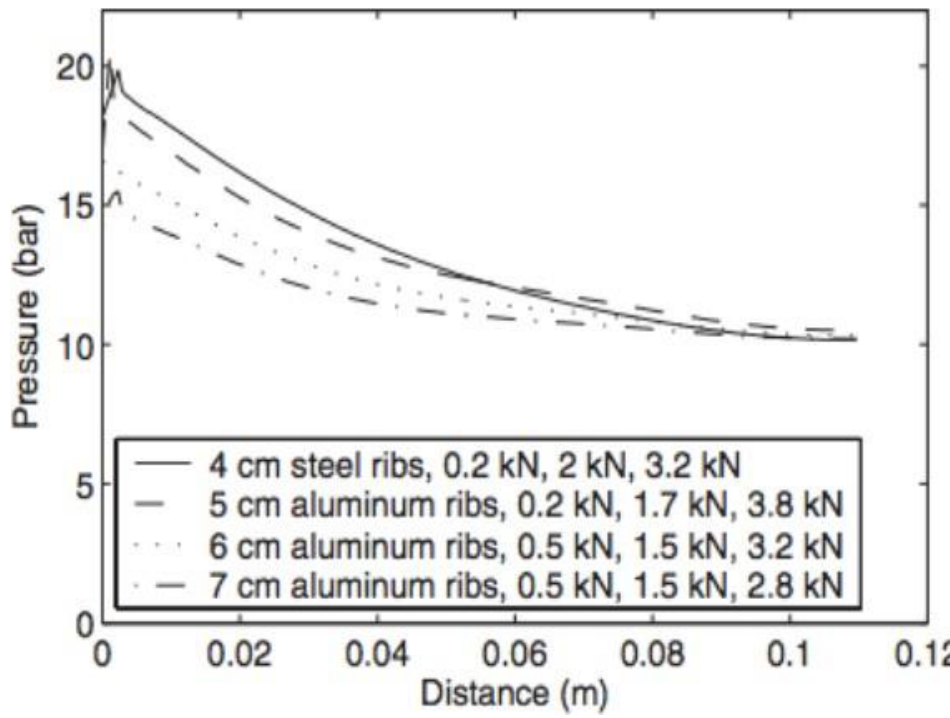
Figure 9. Diagonal pressure values of different structures with optimized load values (first value corresponds to bolts in a corner position; second, for bolts next to the corner position; and the third value corresponds to bolt in the middle position) [146] (open access).